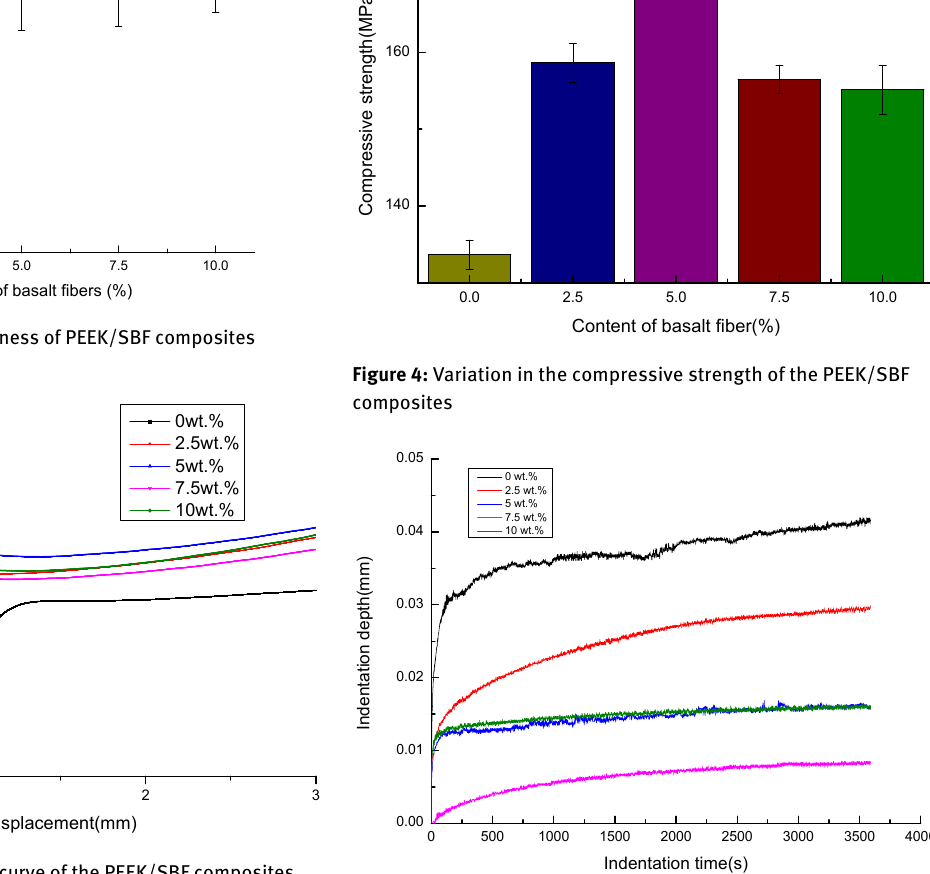
Figure 5: Variation in indentation depth of PEEK/SBF